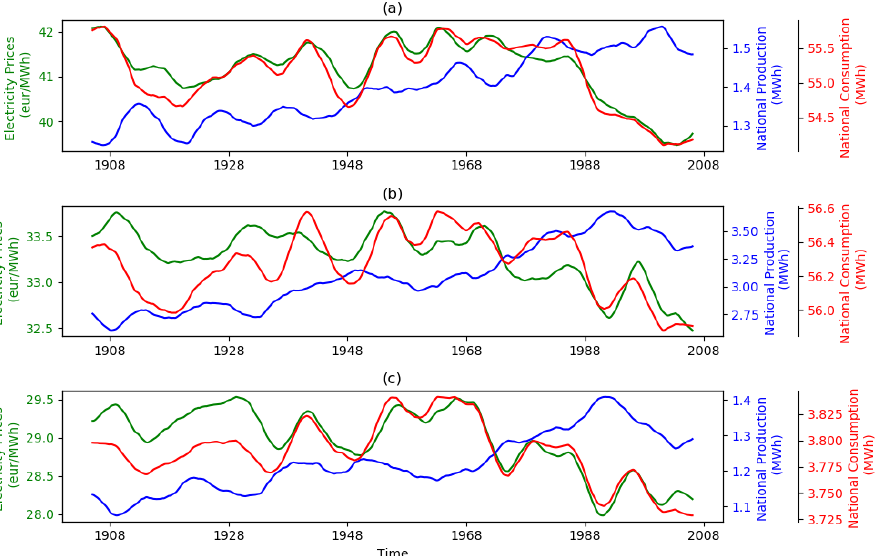
Figure 4. The 10-year moving average of electricity prices (green lines), national electricity consump- tion (red lines), and national wind energy production (blue lines) in ( a ) France, ( b ) Germany, and ( c )